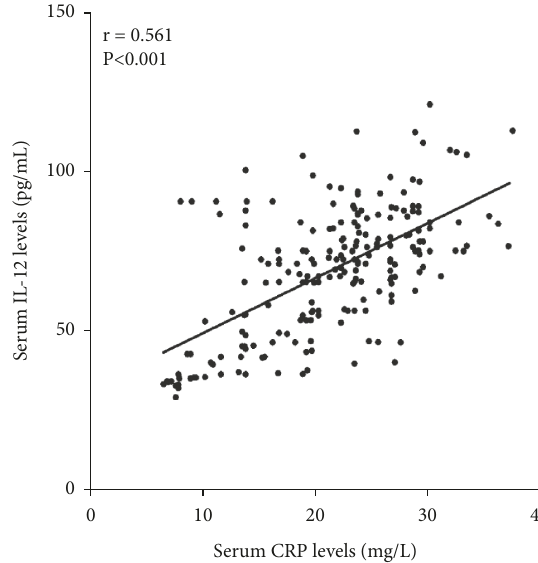
Figure 3: Scatter plot showing the correlation of serum IL-12 levels with serum CRP levels using Spearman’s correlation coefficient.